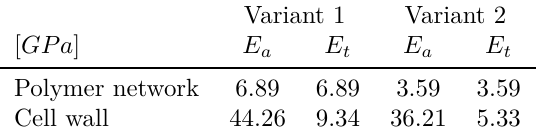
Table 2. Axial and transverse Young moduli of cell wall from two-step micromechanical homogenization.